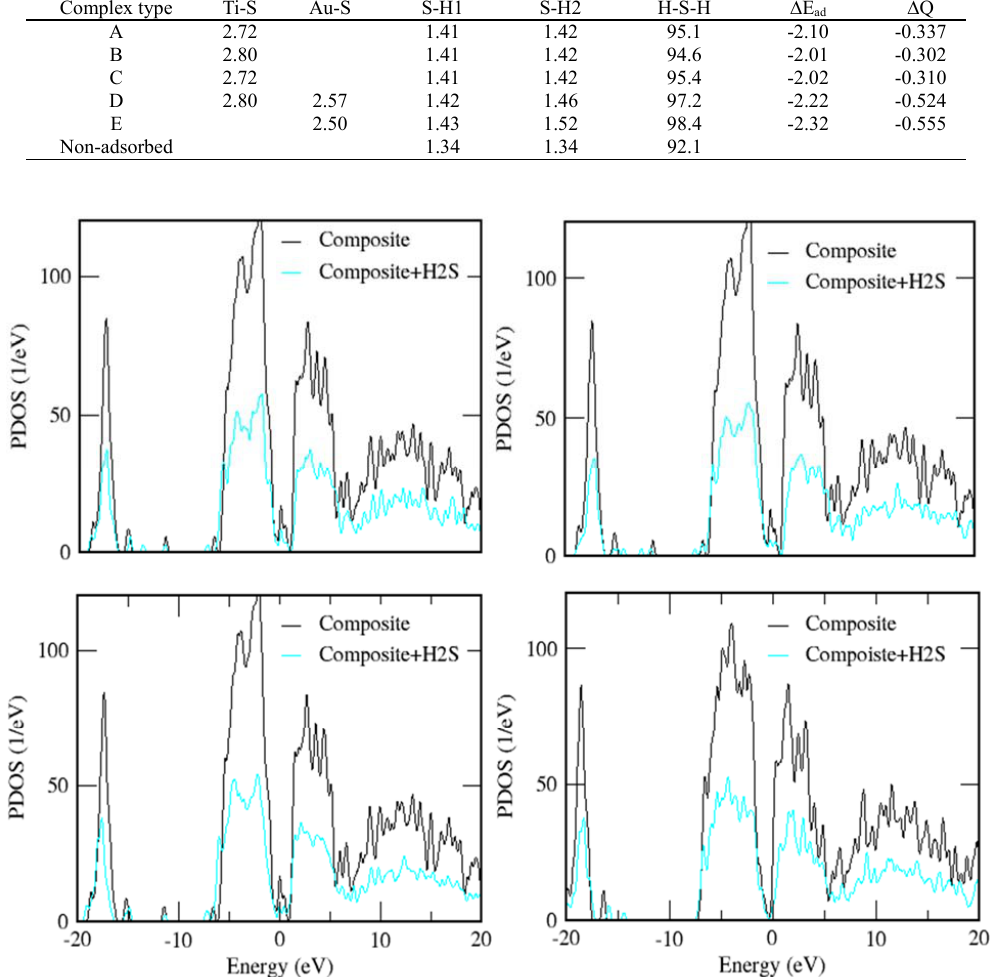
Fig. 4. DOS for the pristine and N-doped TiO 4